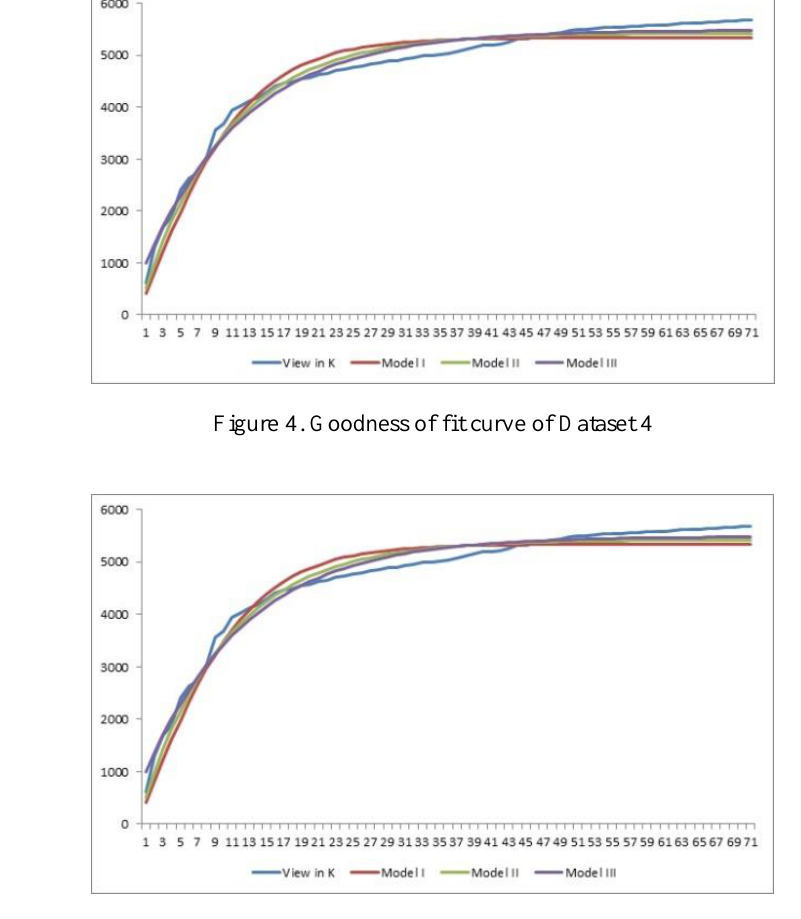
Figure 5. Goodness of fit curve of Dataset 5